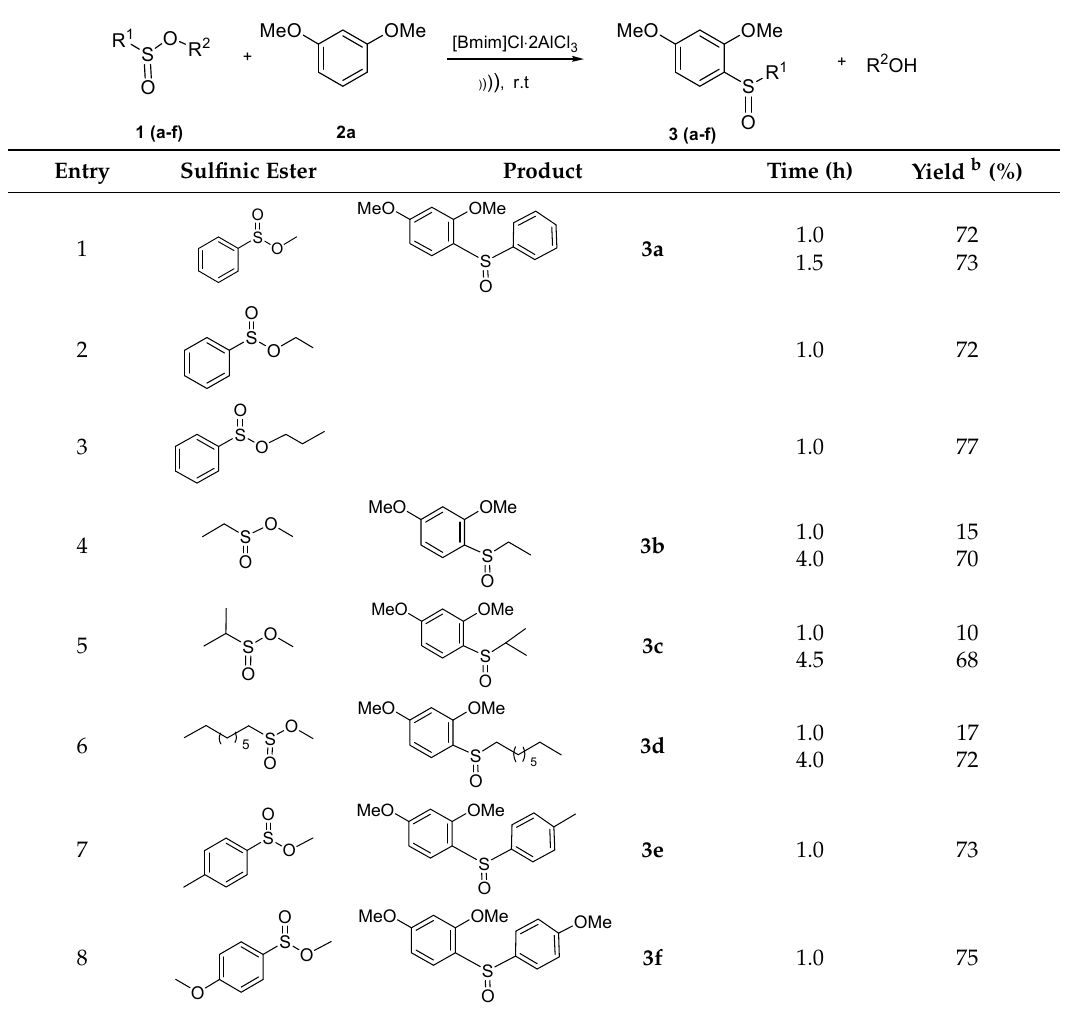
Table 2. Influence of the nature of the alkyl alkane/arenesulfinates on the yields of asymmetrical sulfoxides a .